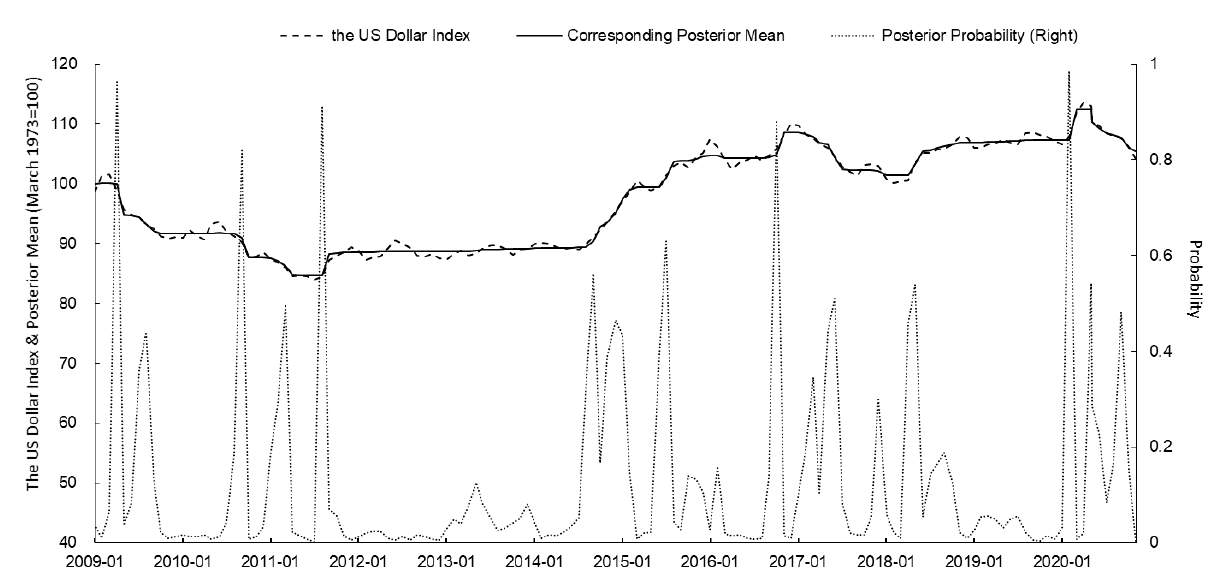
Figure 1. PPM calculation results of WTI crude oil prices and corresponding posterior mean and posterior probability since 2009 (source: NYMEX).